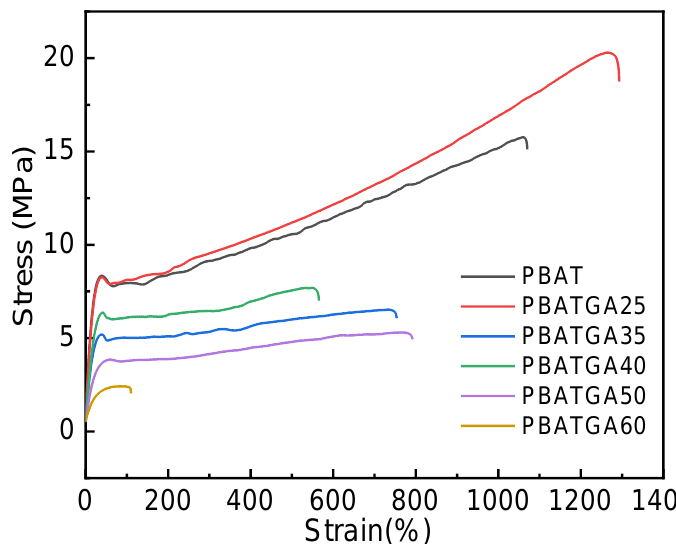
Figure 7. Vicat softening point of the PBATGAs.